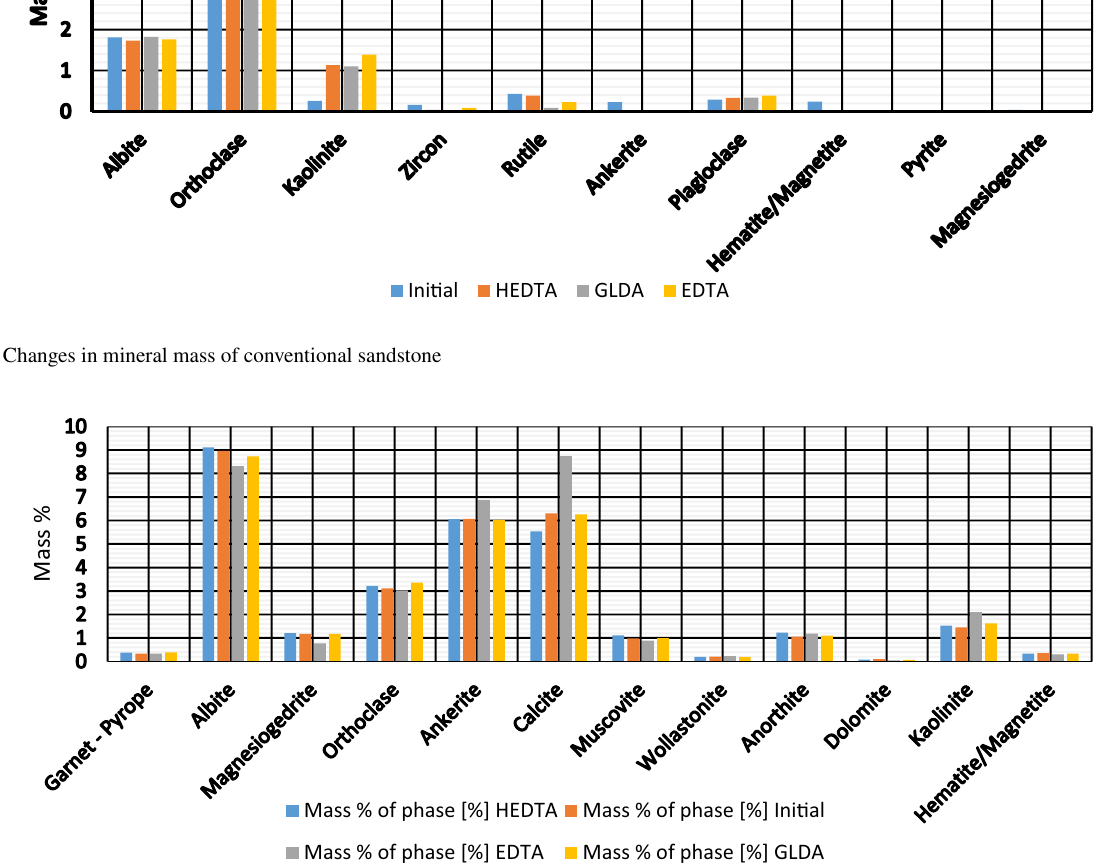
Fig. 5 Changes in mineral mass of tight